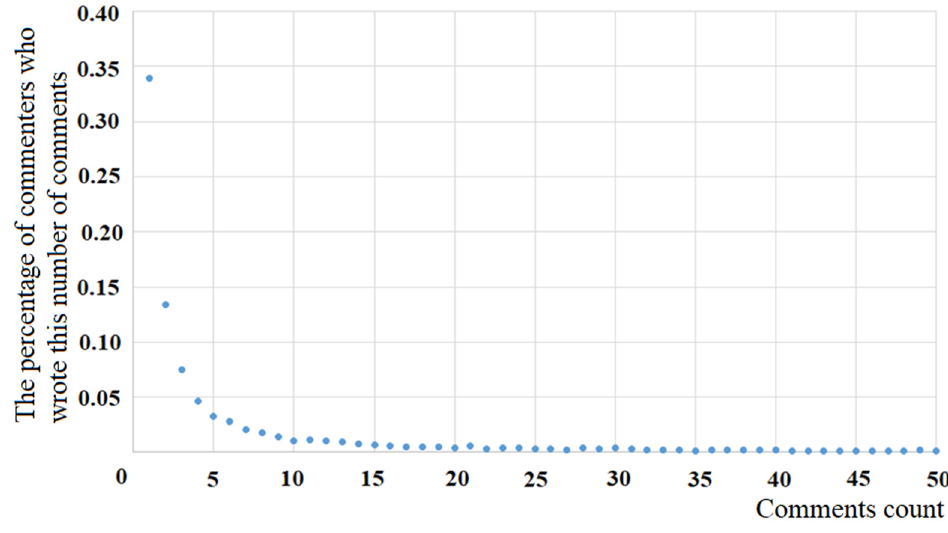
Figure 1. Density of distribution of commentators by their number of comments for the period from